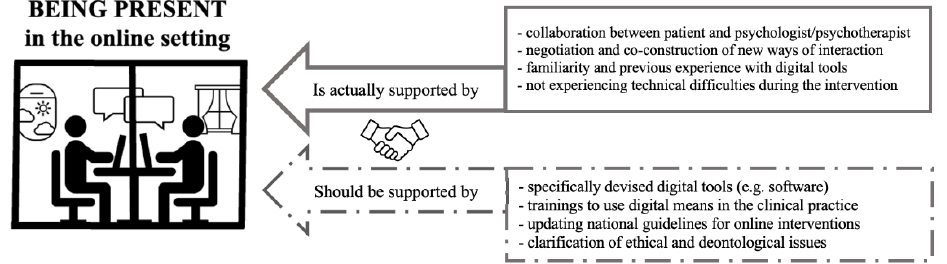
Figure 3. A visual representation of the factors that are involved in the experiencing of presence in the online setting and which need to be addressed to support